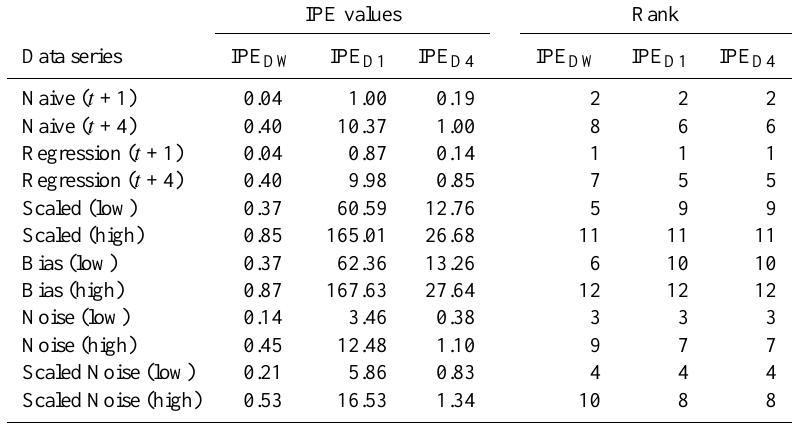
Table 5. IPE D analysis of experimental data